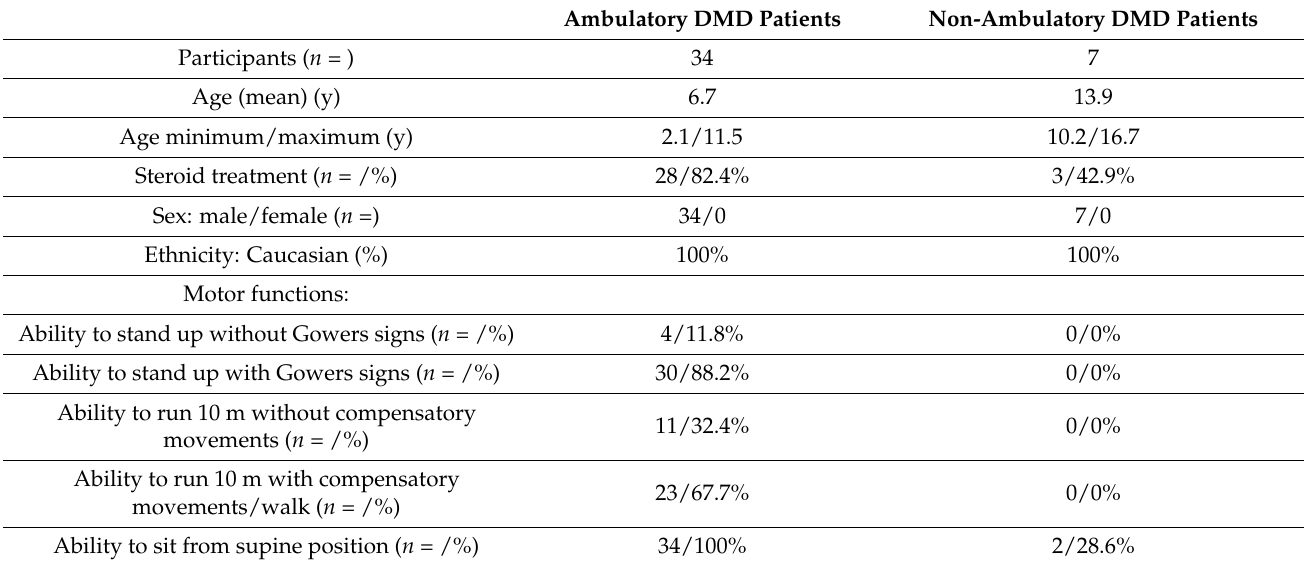
Table 2. General quantitative characteristics of the